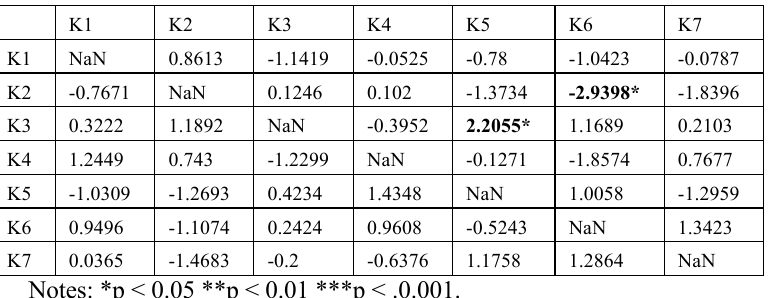
Two-sample t test during PI in the NI